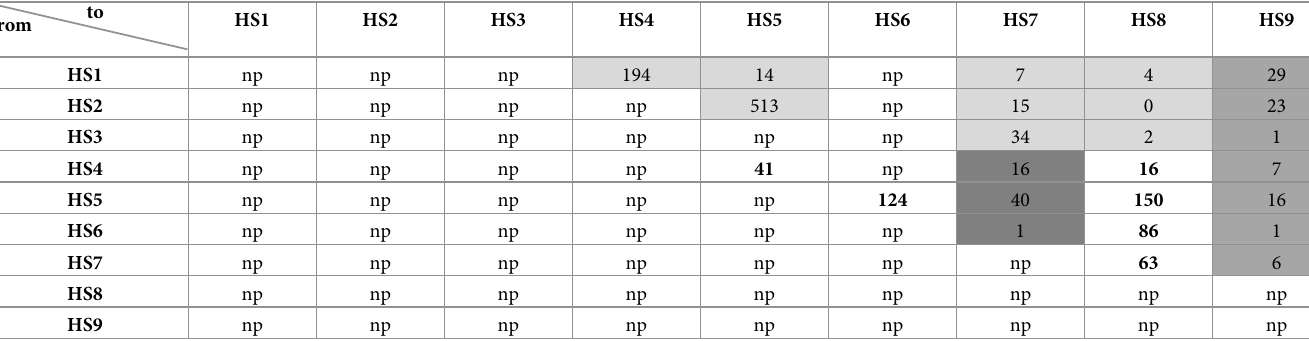
cohort is reported elsewhere [12]. Participants were followed up for a median of 3.08 years in the M0 subgroup and 3.00 years in the M1 subgroup (S4 File). Survival modelling. Table 2 shows the numbers of times that each transition was used during the observed trial period. There were 9 models required in total: 6 for individual transi- tions and 3 for groups of jointly modelled transitions. The shaded groups indicate the three jointly modelled groups: time to first event (i.e. transitions from HS1/2/3 to HS4/5/7/8), time to other-cause death (from HS1-7 to HS9), and transitions to the worst CRPC state (HS7) from the other three CRPC states (HS4/5/6), which was performed jointly due to small event numbers. Numbers with borders indicate the six singly modelled transitions (HS4 to HS5, HS5 to HS6, HS4 to HS8, HS5 to HS8, HS6 to HS8, and HS7 to HS8). All model parameters are given in S4 File. The results of the joint model describing the time to first event, or treatment failure, show that those in the AAP+SOC arm had a significantly longer time to first event than the SOC-only arm. The joint model considering the time to other-cause death depended on age, with the oldest patients having longer time to other-cause death compared to the youngest age group (an apparently contradictory but long-established finding [48]). Other transitions besides first event and other-cause death were also modelled controlling for randomised group, and relevant baseline covariates were assessed for inclusion in each model. Further details on these models and their validation is given in S4 File.